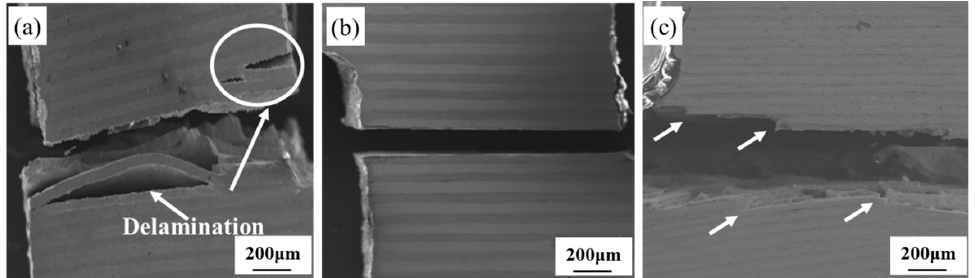
Figure 9. Tensile-shear fracture morphologies of the multilayer TWIP/40Si2CrMo steels with different hot rolling reductions: ( a ) 80%; ( b ) 90%; ( c ) 95%.